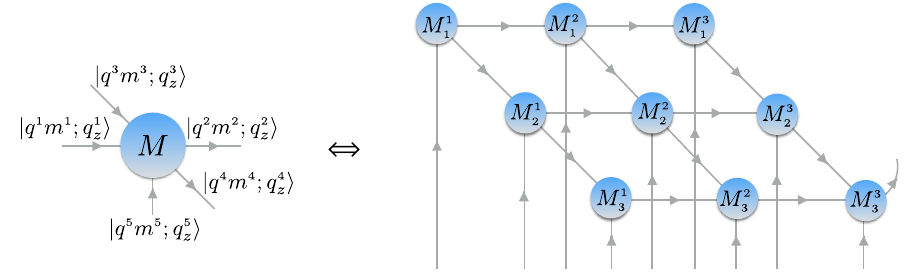
Figure 4: Schematic construction of a PEPS tensor network state. The elementary tensor M associated with each site (left panel) is tiled in a translational invariant fashion into a PEPS (right panel). The index order of its five legs is arbitrary but fixed. Here we use the order ( l , r , t , b , σ ) ≡ ( 1,2,3,4,5 ) for left, right, top, bottom, and local state spaces, respectively. When exploiting symmetries, every individual index (i.e., leg of a tensor or line) represents a state space that must be expressed in terms of symmetry subspaces, throughout. For non-abelian symmetries, a given index describes a state space s that is organized as | s 〉 ≡ | qn ; q a symmetry sector, n a specific multiplet within the symmetry sector q , whereas q indexes the internal multiplet structure which can be split off as a tensor product with a generalized CGTs [ 30 ]